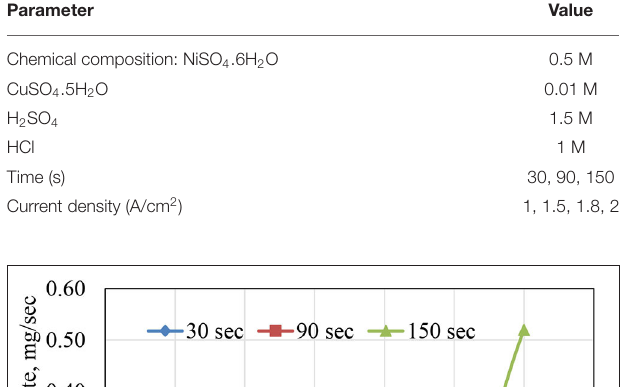
TABLE 2 | Electrolytic bath composition and electrodeposition working conditions of Ni–Cu porous films. Parameter